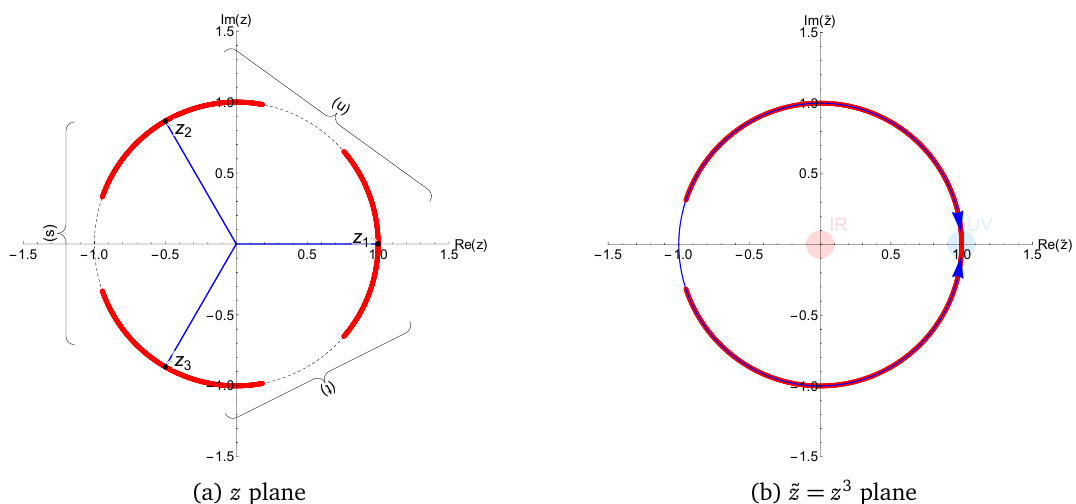
Figure 1: Image of the physical cuts. The blue line on ˜ z = 1 indicates the forward = − 4 / 3, s ≥ 8 / 3. The two trajectories start from ˜ z = − 1 and as s limit s 2 1 they approach ˜ z =